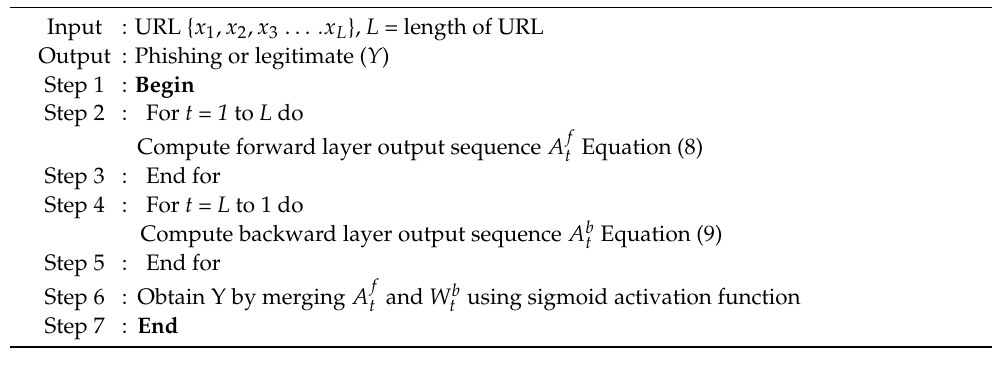
Algorithm 2: Bi-LSTM for phishing URL detection